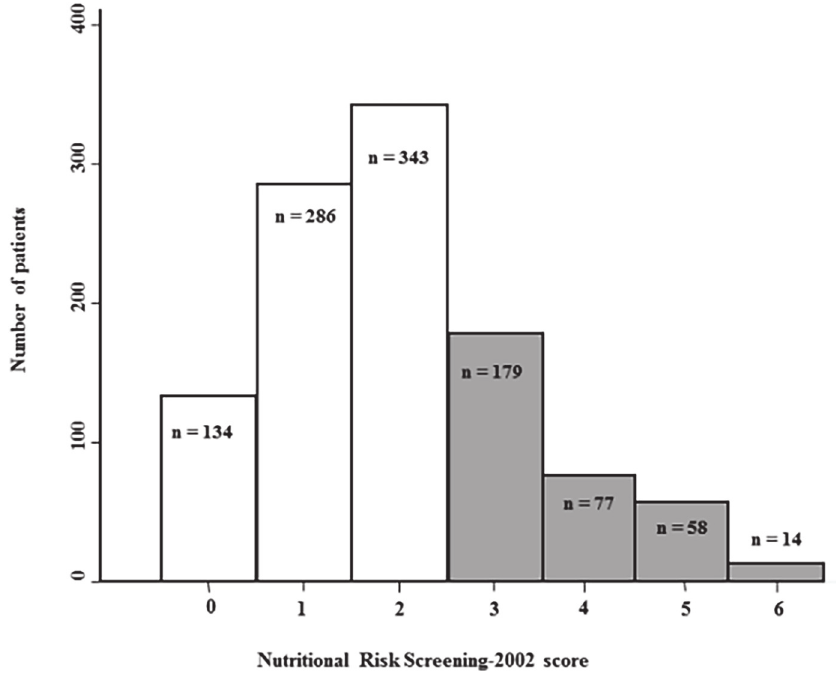
Fig 2. Distribution of the Nutritional Risk Screening-2002 score in the study population (n = 1091). Patients with score (cid:1) 3 are at nutritional risk (grey bars).